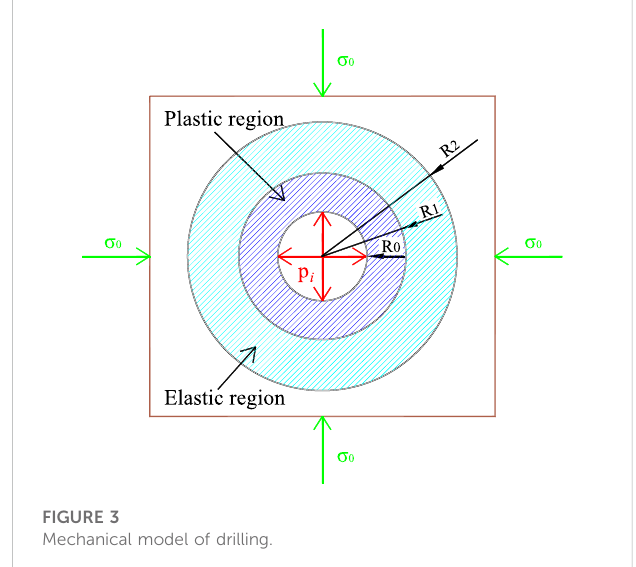
FIGURE 3 Mechanical model of drilling.